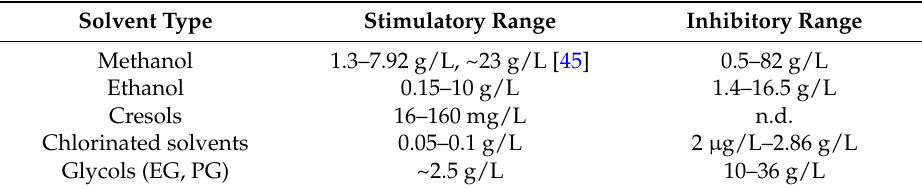
Table 7. Application range of some solvent types for microalgae